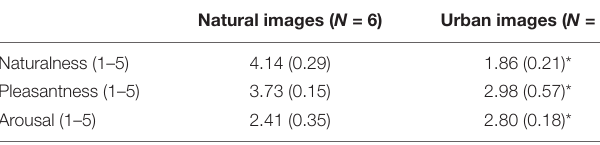
TABLE 1 | Descriptive statistics of images selected for each experimental